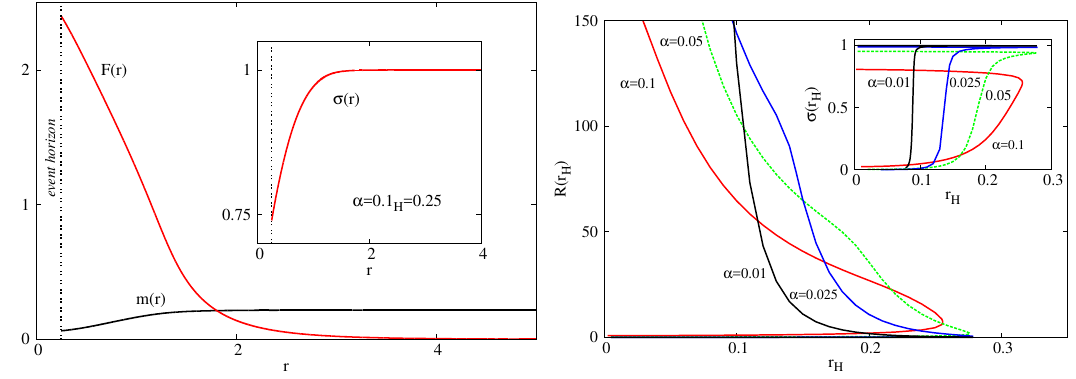
Figure 6 . Left panel: the pro(cid:12)le functions of a typical spherically symmetric BH with Skyrme hair. Right panel: the values, at the horizon, of the Ricci scalar R and of the metric function (cid:27) are shown as functions of the horizon radius r H , for several values of (cid:11) .